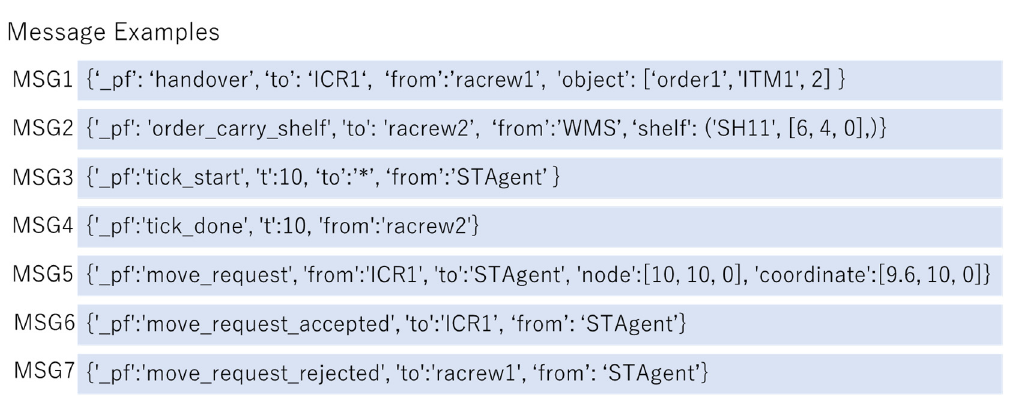
Figure 3. Message architecture (examples written in Python syntax). Table 1. Performatives for logistics warehouse.